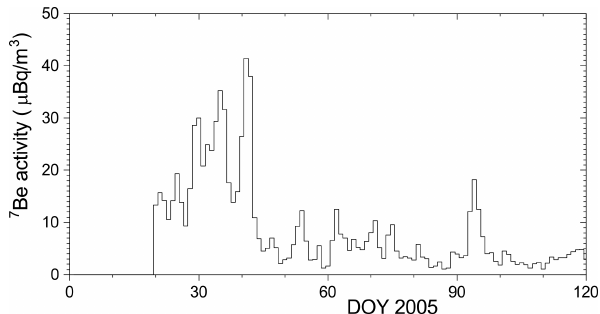
Figure 8. Modeled activity of 7 Be produced by the SPE on 20 Jan- uary 2005 in near-ground air in